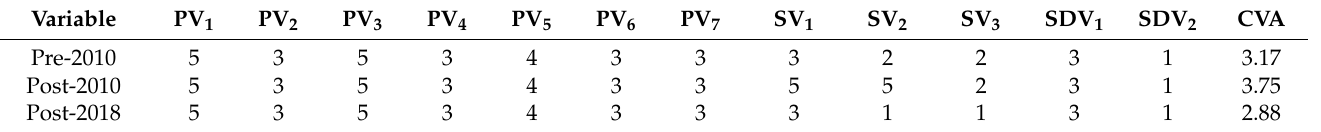
Table 15. Summary of the coastal vulnerability assessment (CVA) result.